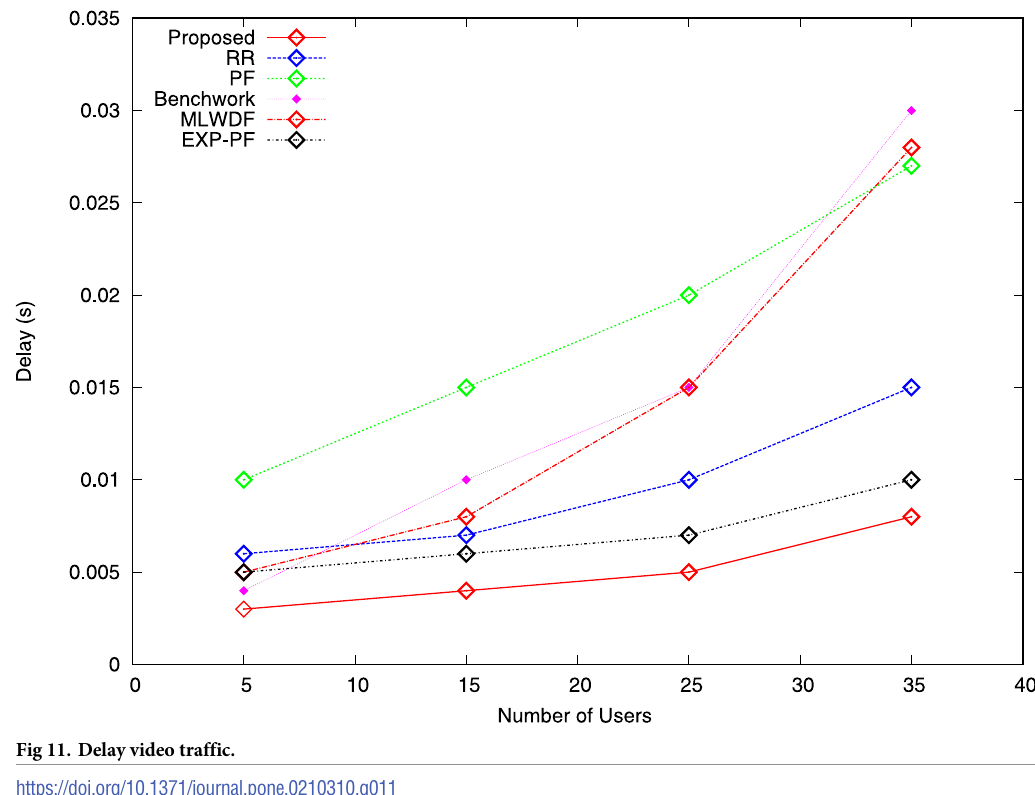
Fig 11. Delay video traffic.